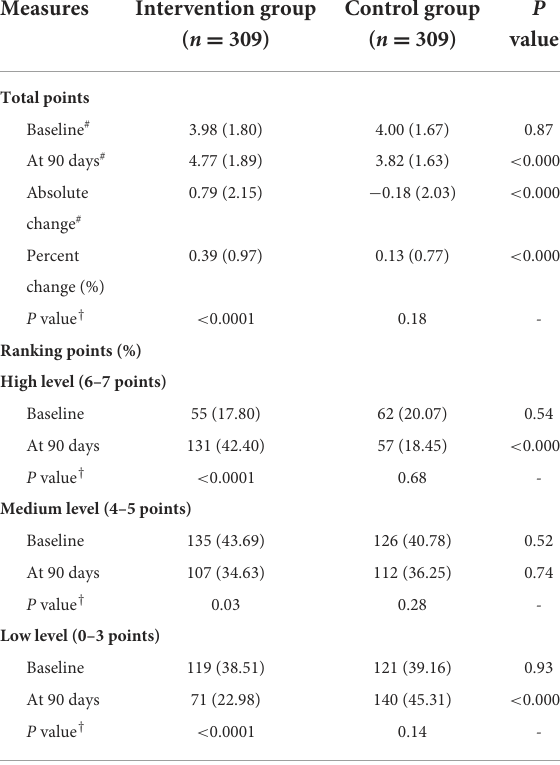
TABLE 7 The rational medication belief evaluation of elderly patients with